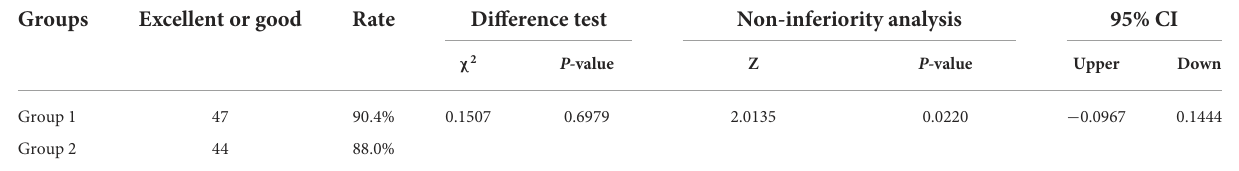
TABLE 5 Clinical effective rate a